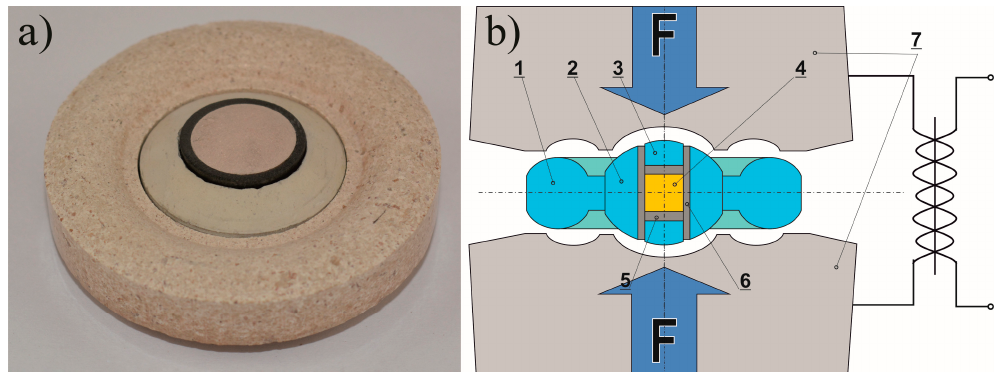
Figure 6. Figure 2 View of the high pressure gasket assembly ( a ) and cross-section diagram of the sintering process ( b ), where: 1—ceramic gasket (outer part); 2—ceramic gasket (inner part); 3—ceramic disc; 4—sample; 5—graphite disc; 6—graphite tube; 7—sintered carbide dies [133].